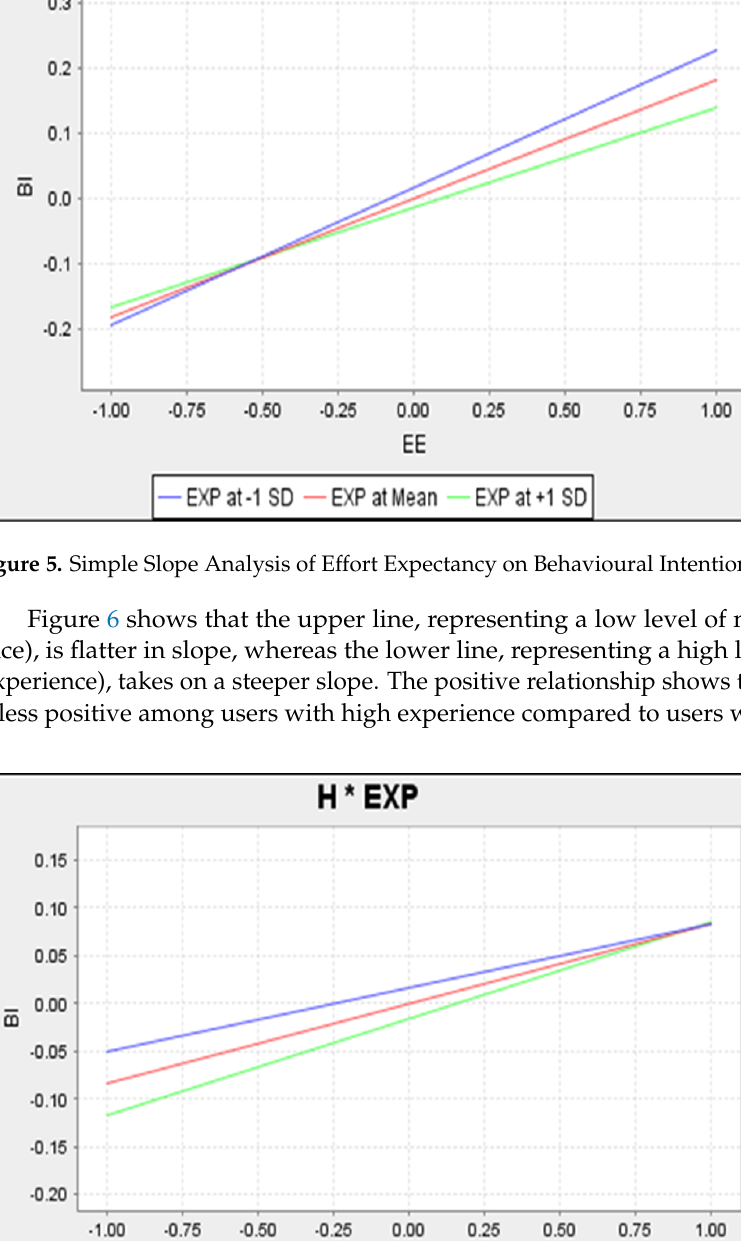
Figure 6. Simple Slope Analysis of Habit on Behavioural Intention. Figure 7 presents the privacy concerns-behavioural intention inverse relationship. High privacy concerns, therefore, correspond to low behaviour intention levels. The lower line, representing high experience level, indicates a steeper slope and this is attributed to the negative interaction effect. Therefore, the relationship was more negative among high-experienced users compared to low-experienced ones. Experience had a negative moderating effect on habit and technology use (See Table 5), with the plot in Figure 8 showing that high experience corresponds to a lower habit–technology use